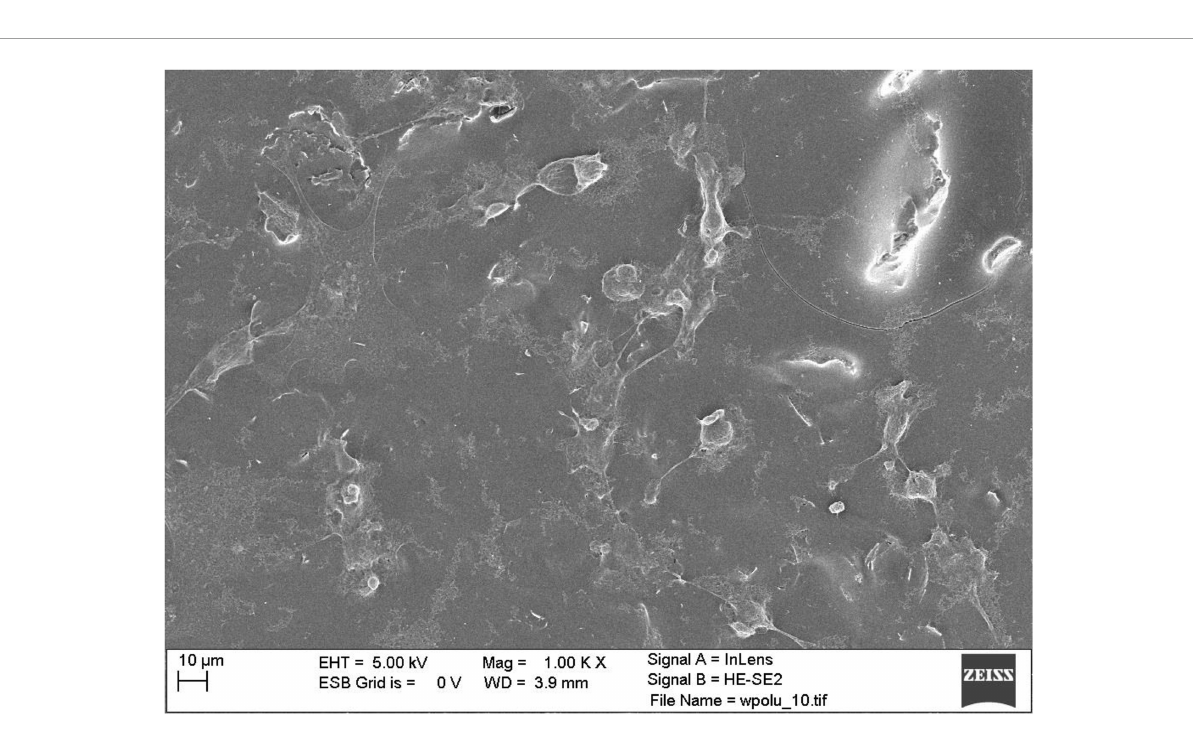
FIGURE6 Scanning electron microscope photograph of control group neural stem cells on graphene layer without